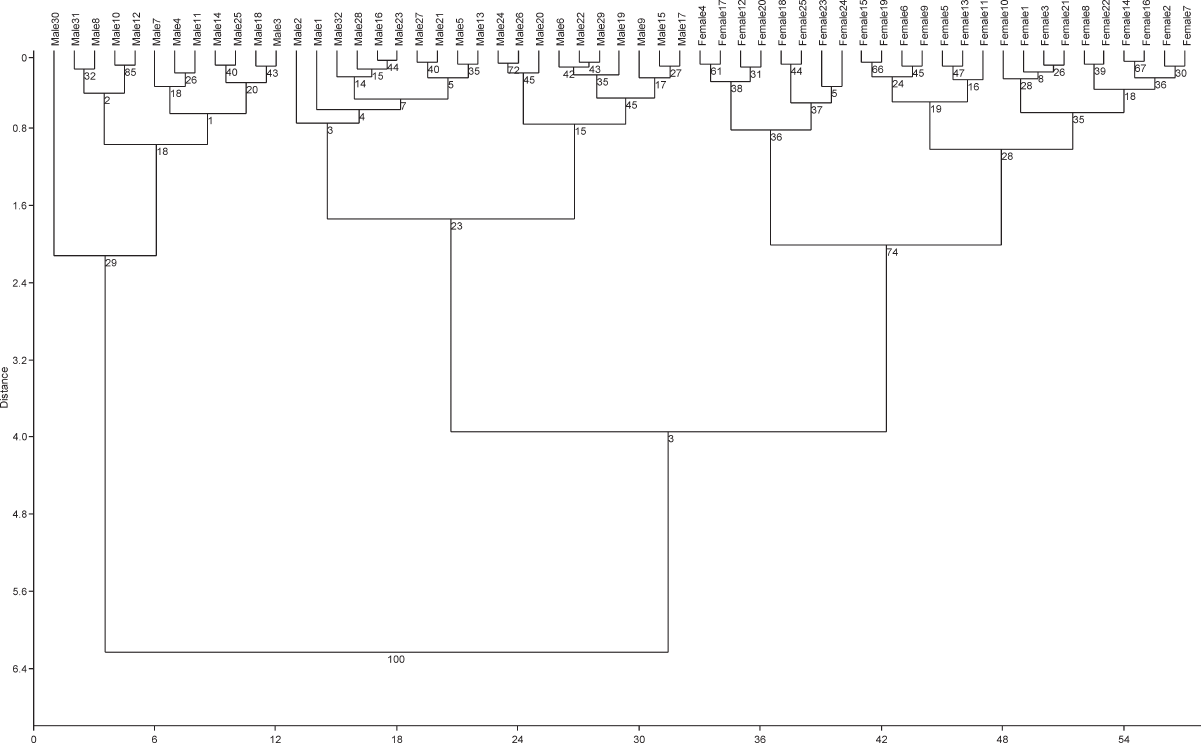
Figure 14. Dendogram obtained with Ward’s Cluster Analysis methods for H. prasinata. 1,000 bootstrap